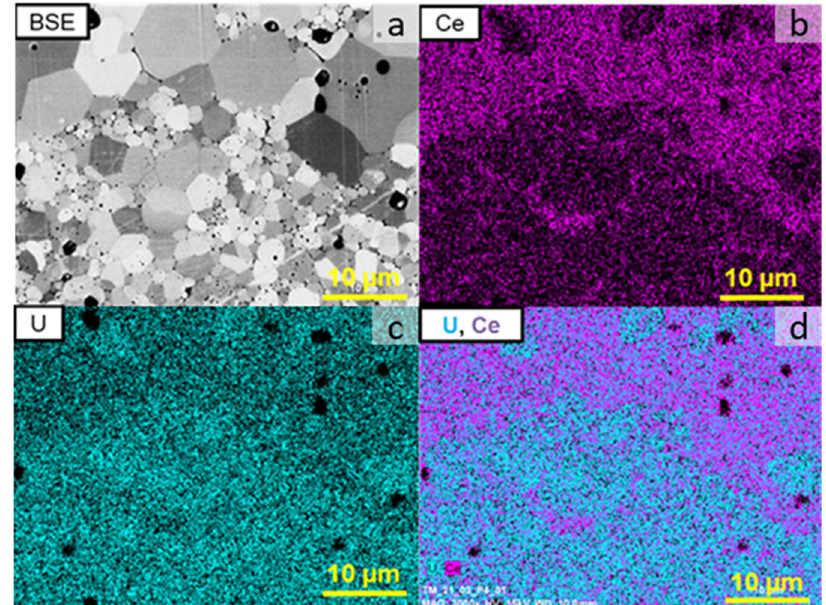
Fig. 4 SEM observations of heterogeneous material before alteration. Elemental maps of the heterogeneous U 0.92 Ce 0.08 O 2 material, a BSE mode; b Ce map; c U map; d U and Ce map. Table 3. Results obtained from XPS analyses performed on homogeneous materials.